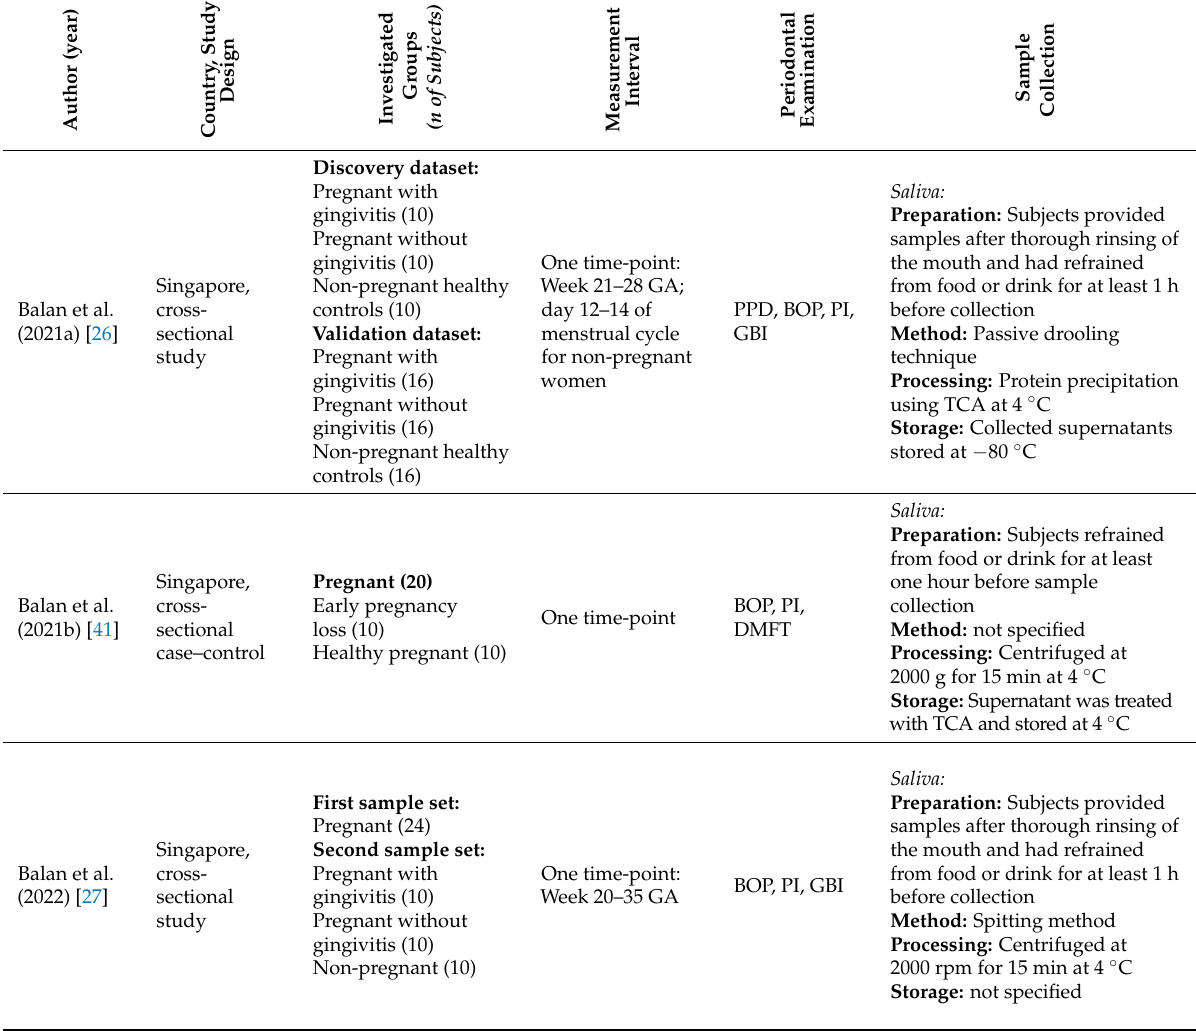
Table 1. Study groups with healthy pregnant and diseased pregnant